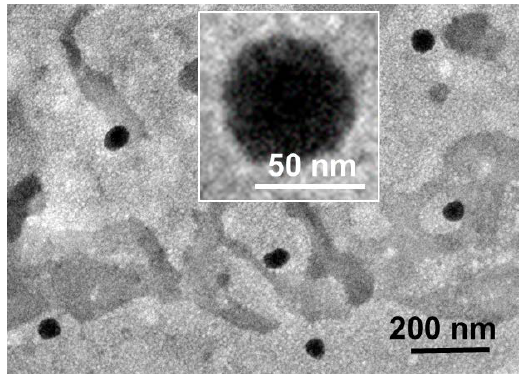
Figure 3. TEM image of PR-NLCs (scale bar 200.0 nm).